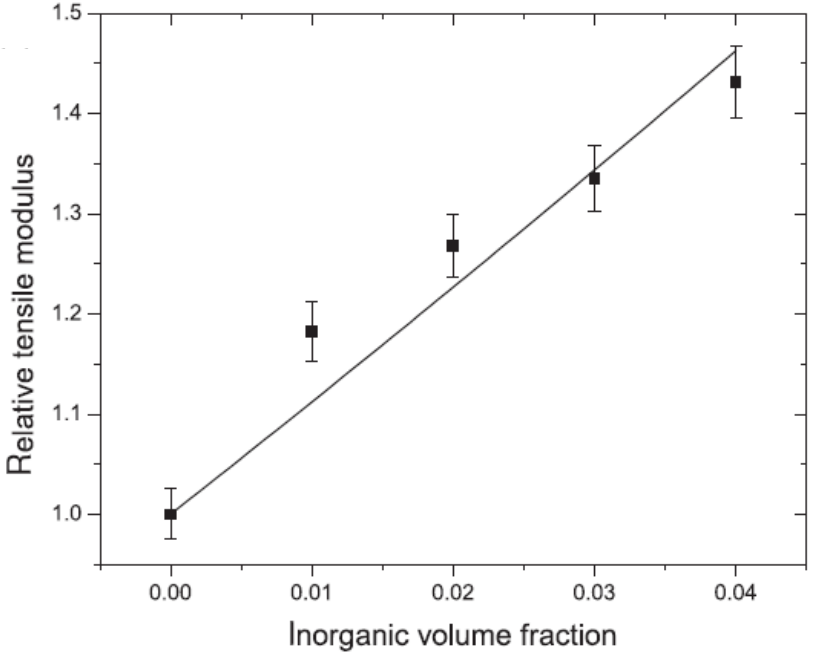
Figure 29. Improvement of the tensile modulus of the polypropylene nanocomposites as a function of the filler volume fraction. Reproduced from reference